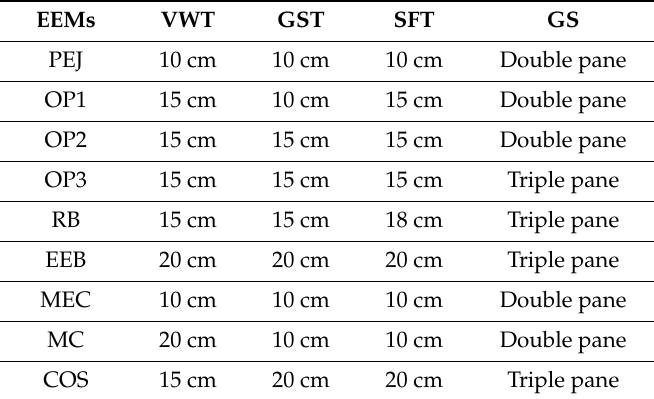
Table 11. Detected optimal constructive solutions concerning di ff erent EEMs for climatic zone F (VWT, insulation thickness in vertical wall; GST, insulation thickness in the ground slab; SFT, insulation thickness in the second last floor; GS, glazing